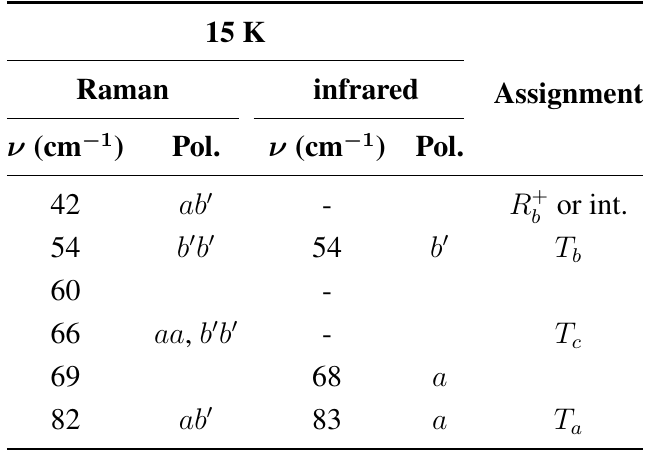
Table 7. Experimental frequencies and assignments of the (TMTTF) obtained from our Raman and infrared measurements at room temperature and T ≈ 15 K. Here Pol. denotes the polarization